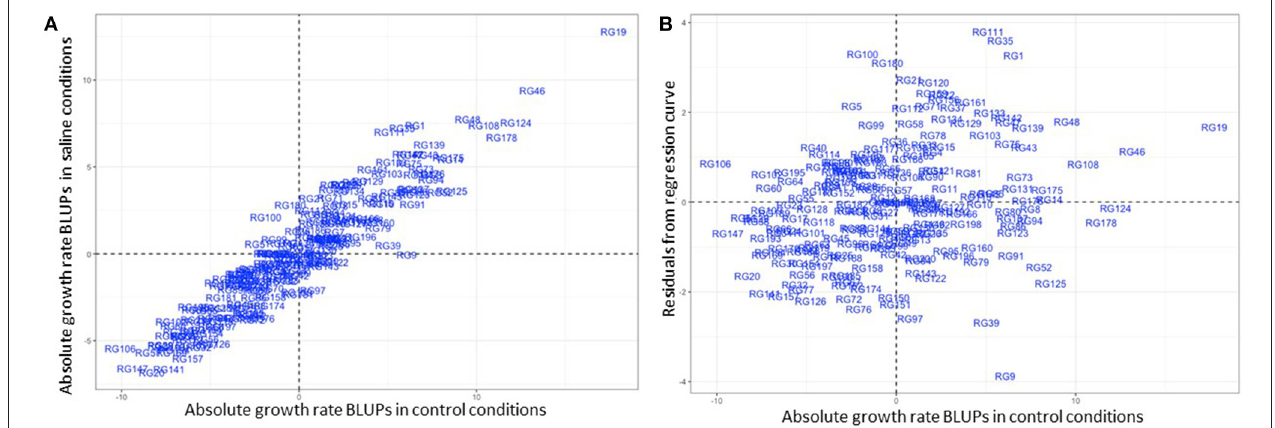
FIGURE 5 | An example of a salinity tolerance measure: Regression of salinity treatment-derived best linear unbiased predictors (BLUPs) on control treatment-derived BLUPs, with the residuals used to quantify salinity tolerance. This example shows absolute growth rate (AGR) obtained in the glasshouse, with the graph on the left showing salinity treatment-derived AGR BLUPs plotted against control treatment-derived BLUPs. The graph on the right shows residuals from the regression curve plotted against control treatment-derived BLUPs. A random distribution of the data shows there was no influence of AGR in control conditions on the residuals. Genotypes in the two upper quadrants demonstrate salinity tolerance with respect to this